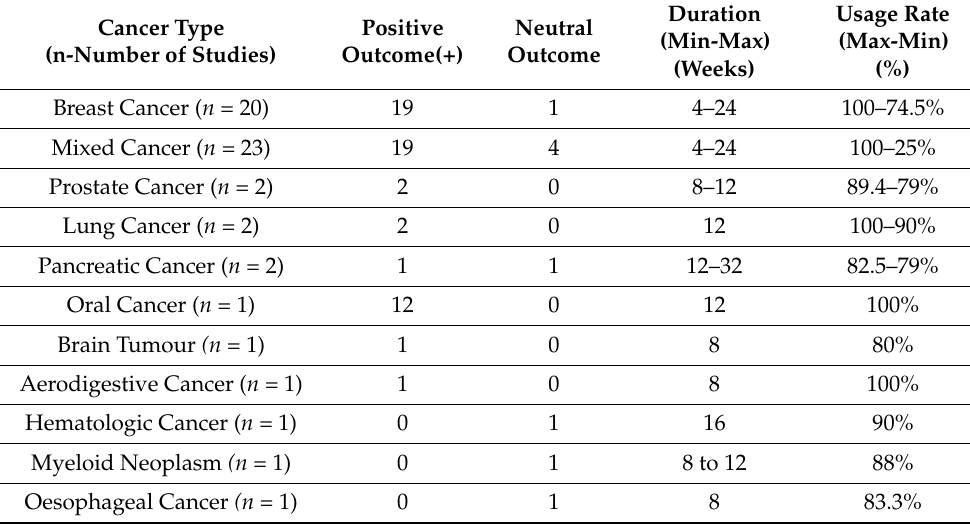
Table 2. Cancer type, cancer health outcomes, duration and usage rate of mobile-app-based interven- tions for different cancer types.